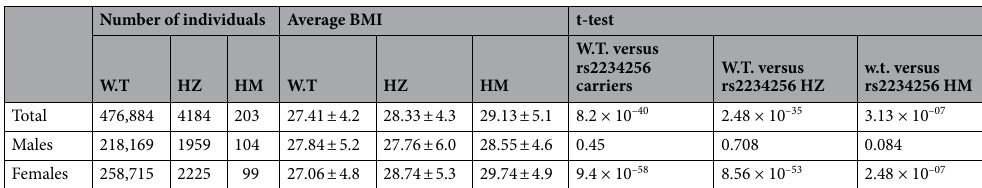
Table 2. Average BMI of individuals with and without the rs2234256 SNP. W.T . wildtype, HZ Heterozygous, HM Homozygous.